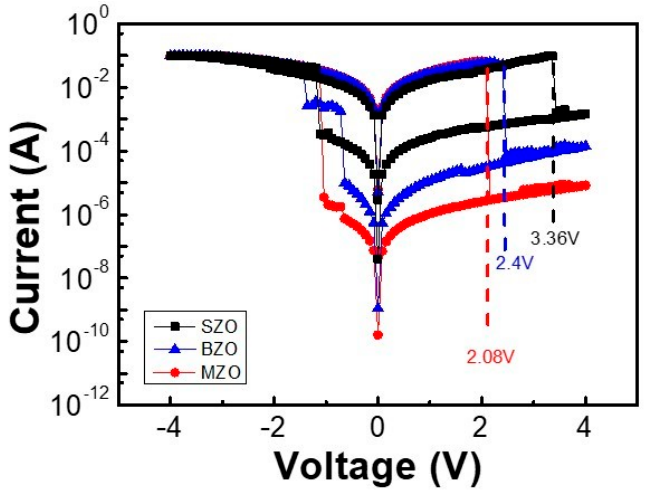
Figure 4. Typical I–V characteristic of AZO x -based RRAM plotted on a semi-logarithmic scale. (A = Sr, Ba,